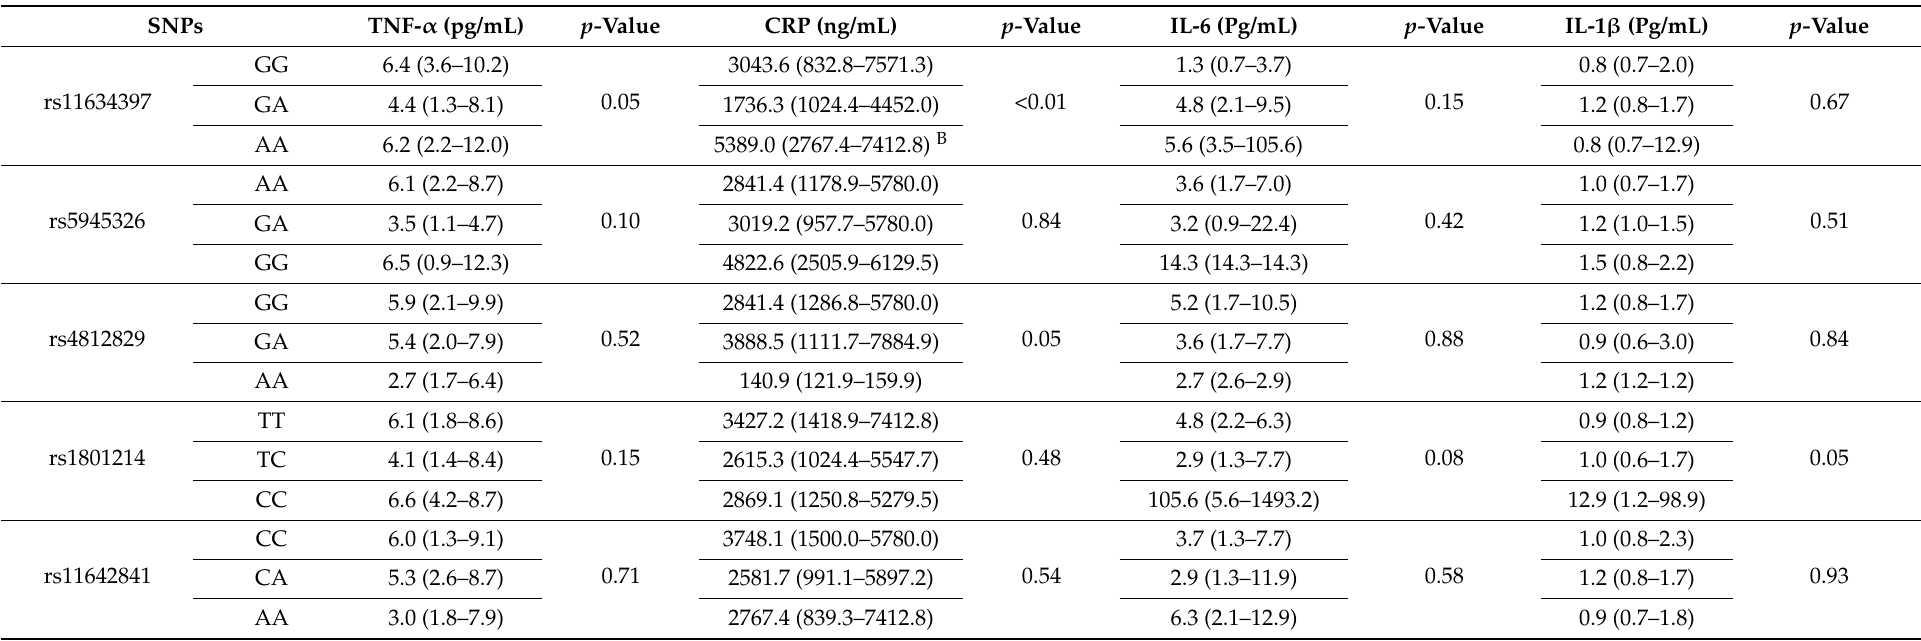
Table 4. Inflammatory markers according to selected